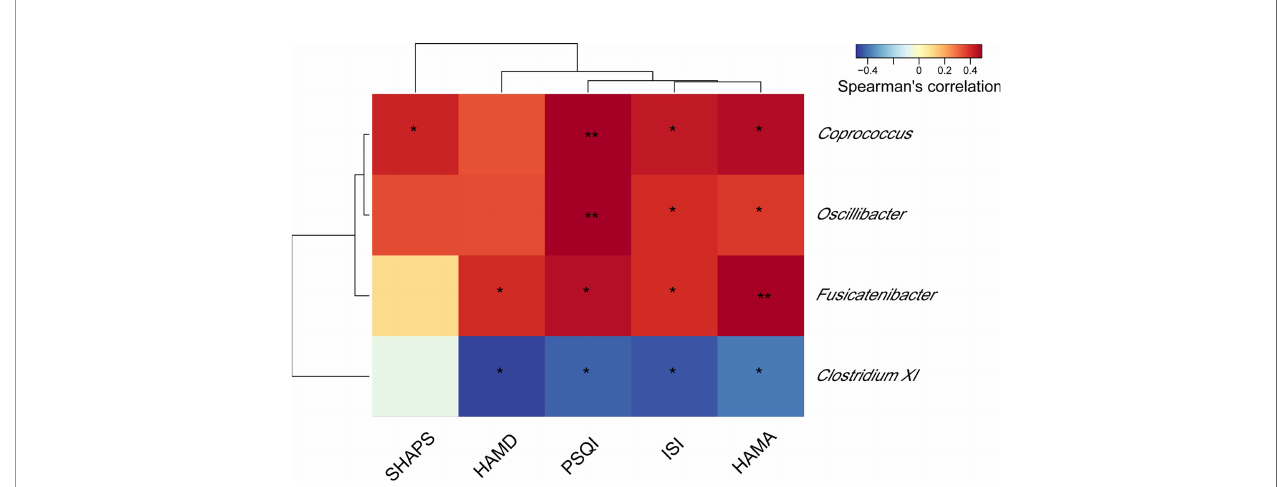
FIGURE 7 | Heat map of the Spearman correlation analysis between gut microbes and sleep/mood index. * P < 0.05; ** P < 0.01. PSQI, Pittsburgh Sleep Quality Index; ISI, Insomnia Severity Index; HAMA, Hamilton Anxiety Rating Scale; HAMD, Hamilton Depression Rating Scale; SHAPS, Snaith-Hamilton Pleasure Scale.